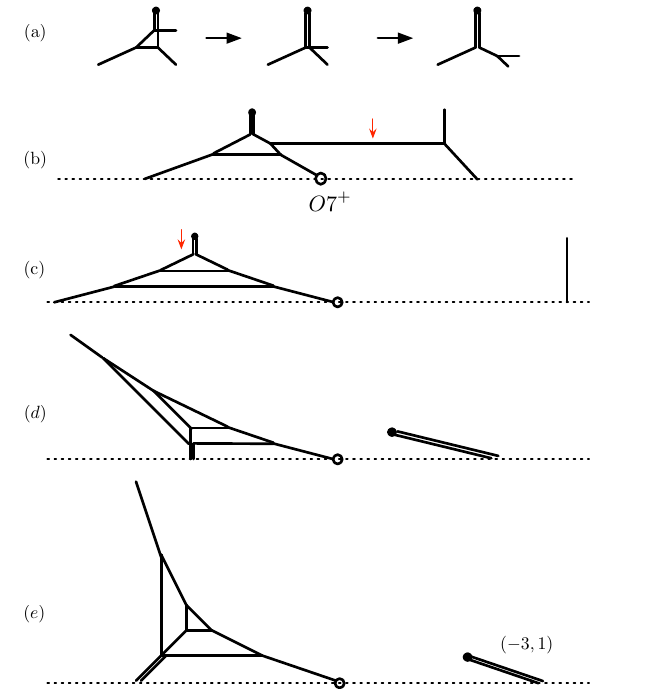
Figure 16. Deformations of the 5-brane web given in figure 15(b) leading to a 5-brane web for P 2 ∪ F 6 + “1 Sym